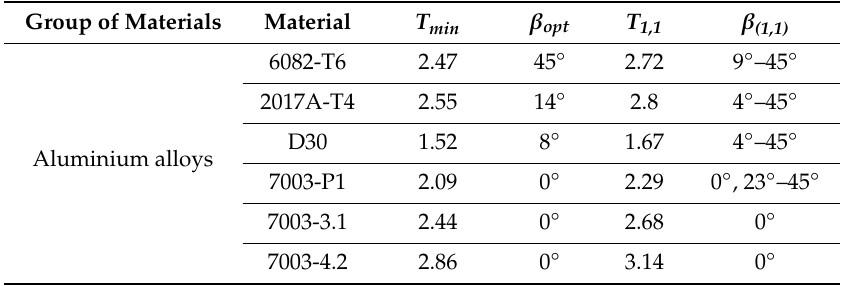
Table 5. Details of condition